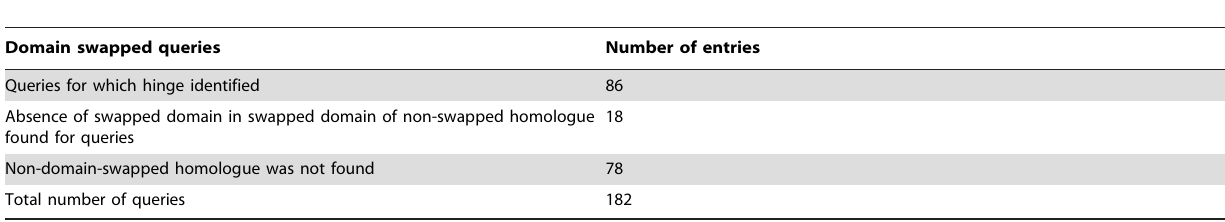
Table 1. Performance of HIDE algorithm for non-redundant entries from 3D-swap database.